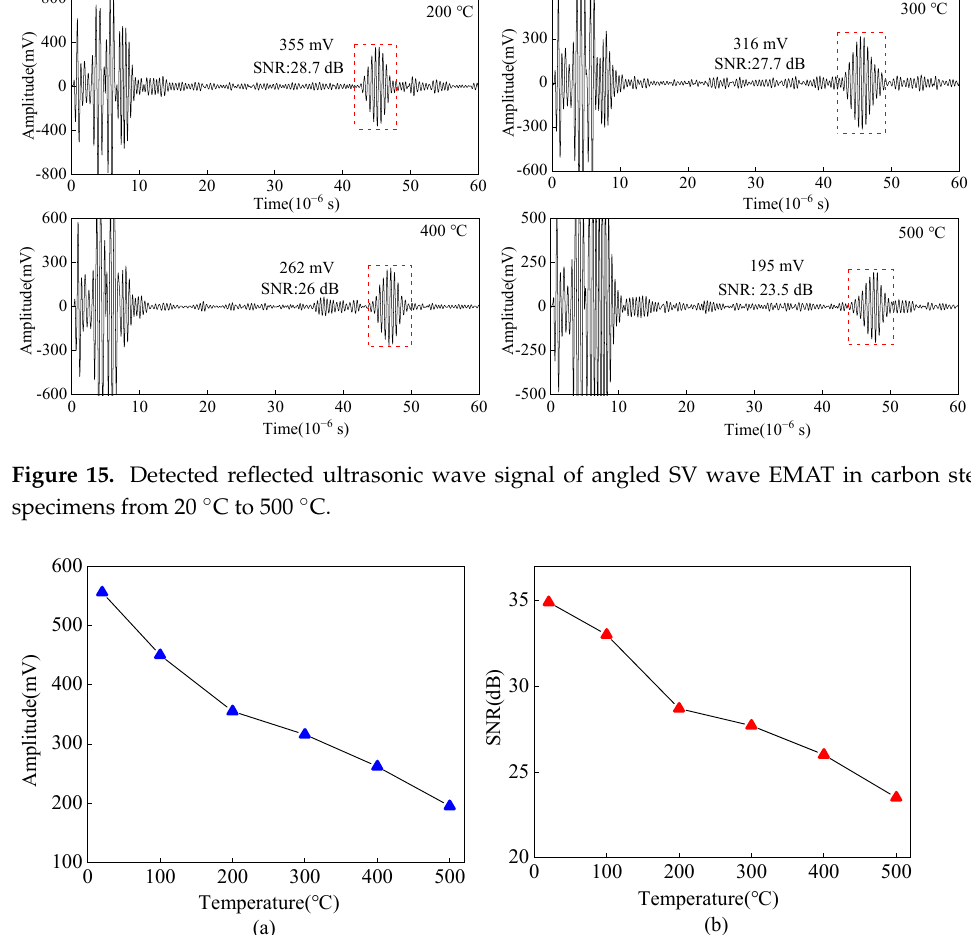
Figure 16. ( a ) Amplitude ( b ) SNR of the block-corner reflected wave from angled SV wave EMAT in carbon steel specimens from 20 °C to 500 °C.